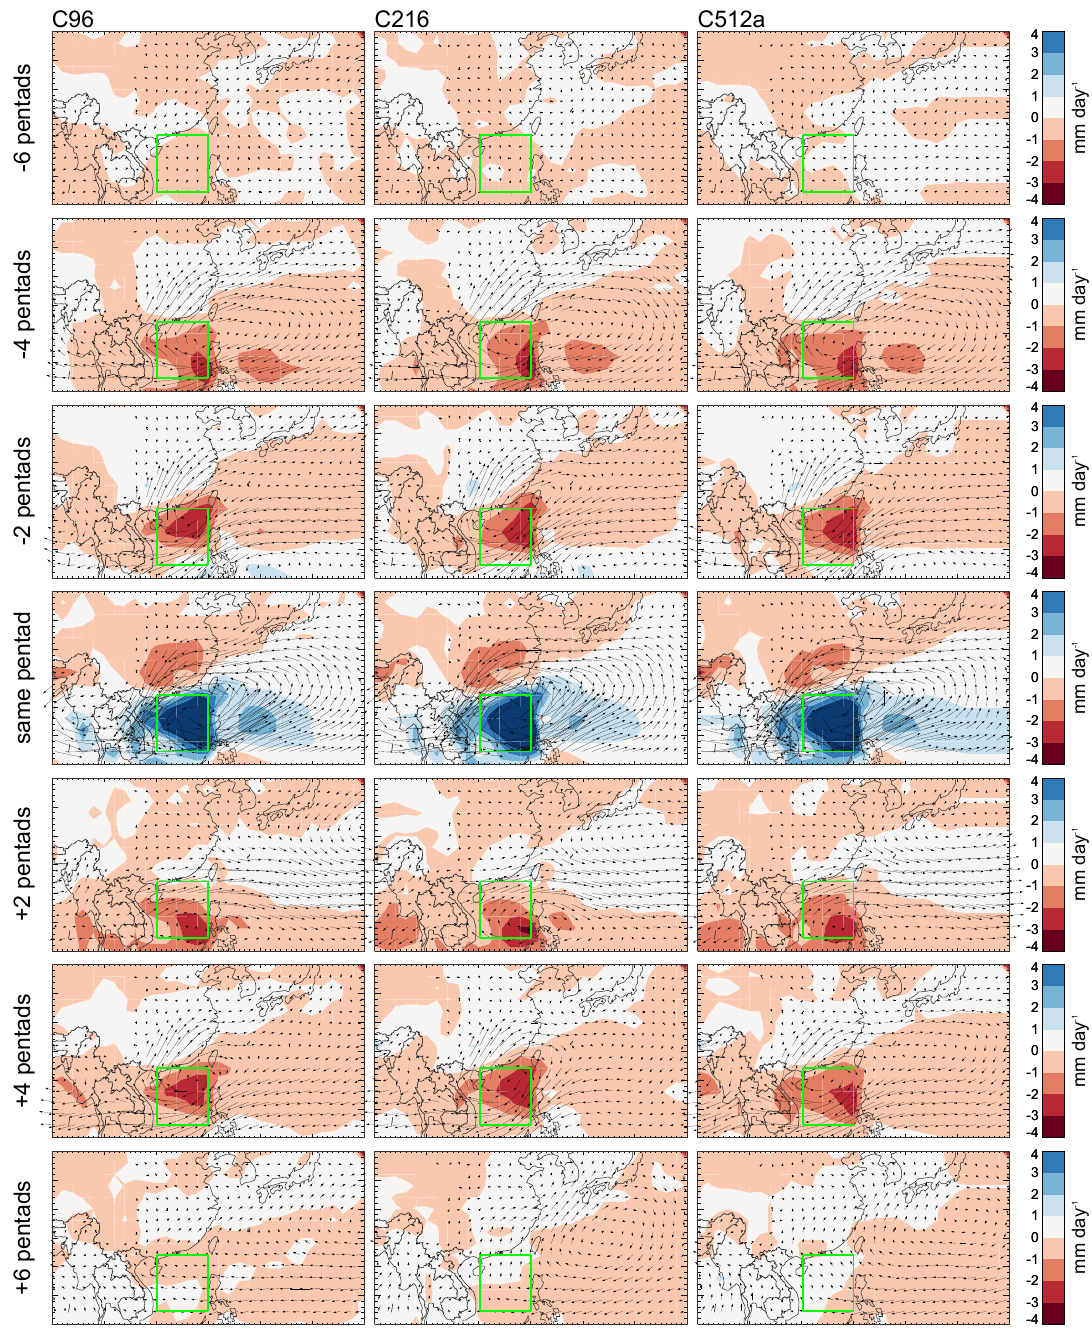
Figure 7. As in Fig. 6, but for C96, C216, and C512a.